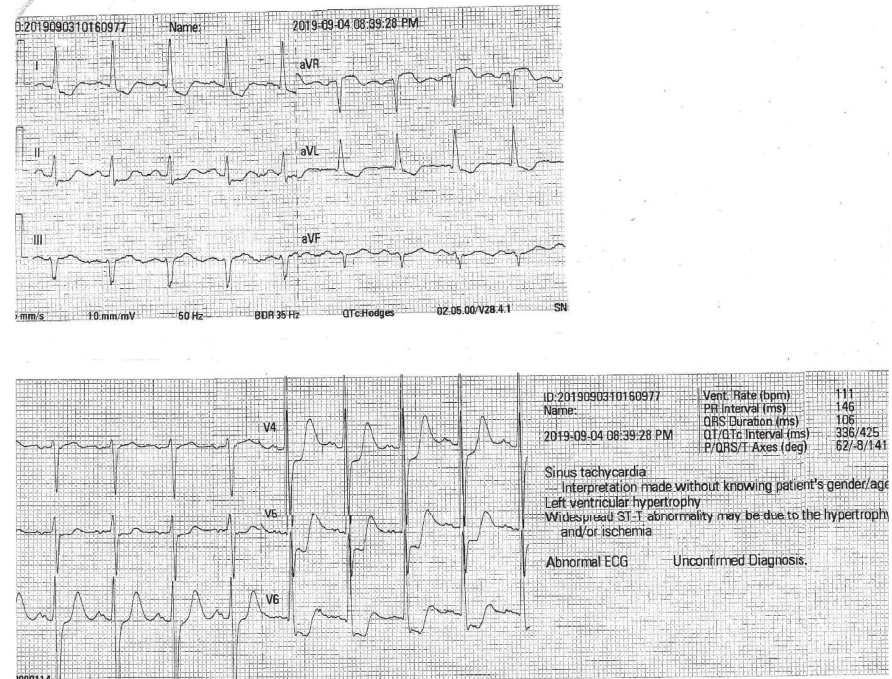
Figure 2: Repeat electrocardiogram taken after admission, showing ST-segment depression in the chest leads,